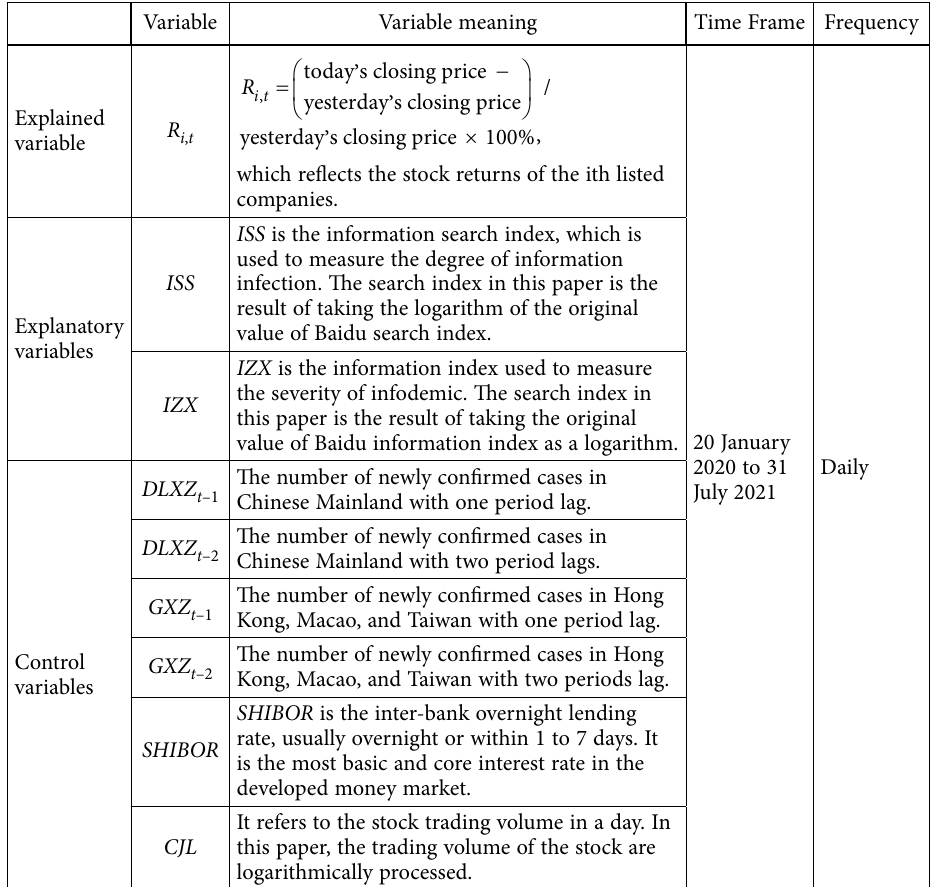
Table 2. Variable